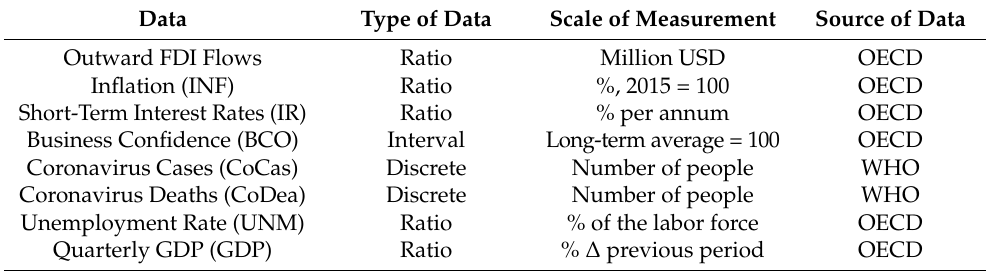
Table 1. Summary of